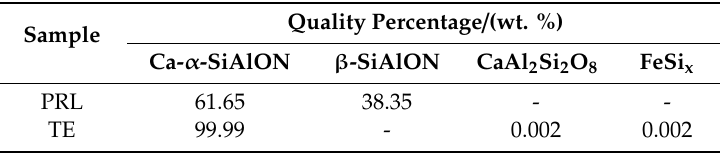
Table 3. The result of quantitative phase